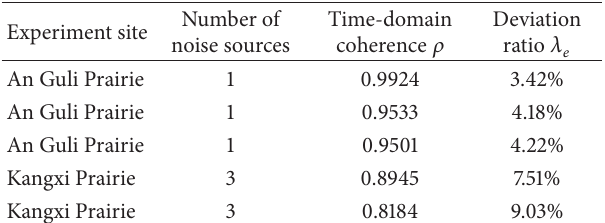
Table 1: The results of signal